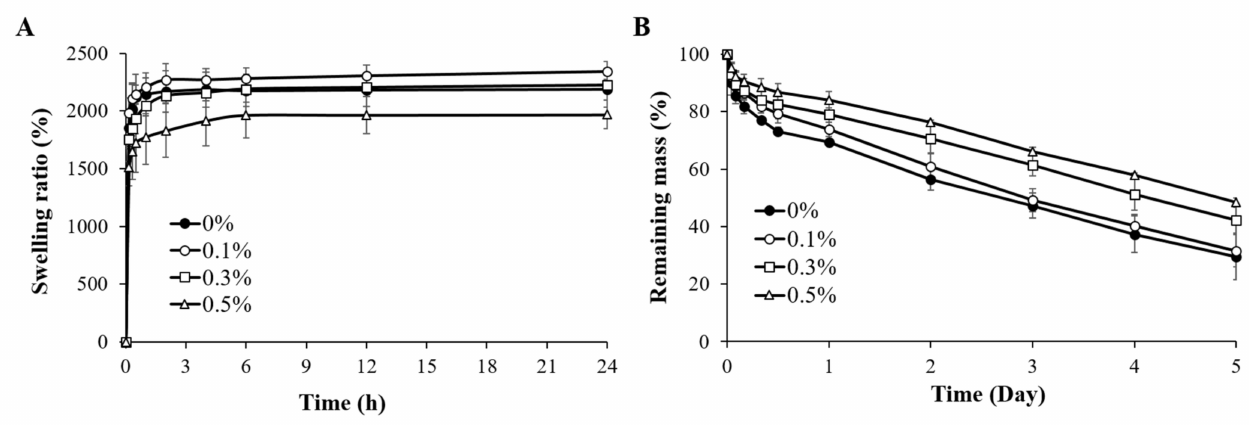
Figure 6. Physical properties of the suture fiber reinforced gelatin 3D scaffold. ( A ) Swelling ratios over time ( n = 4). ( B ) Degradation of the suture fiber reinforced gelatin 3D scaffolds by 2 U/mL collagenase ( n =